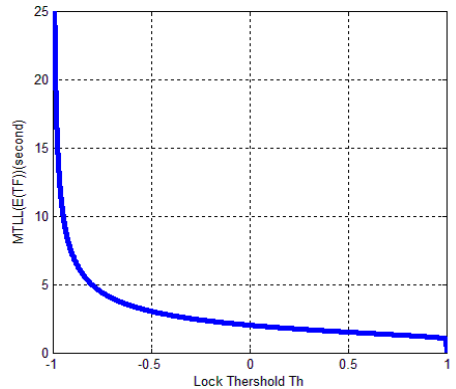
E T Th Figure 7. Relation between MTLL ( E { T F } ) and threshold Th under no signal presented situation. F